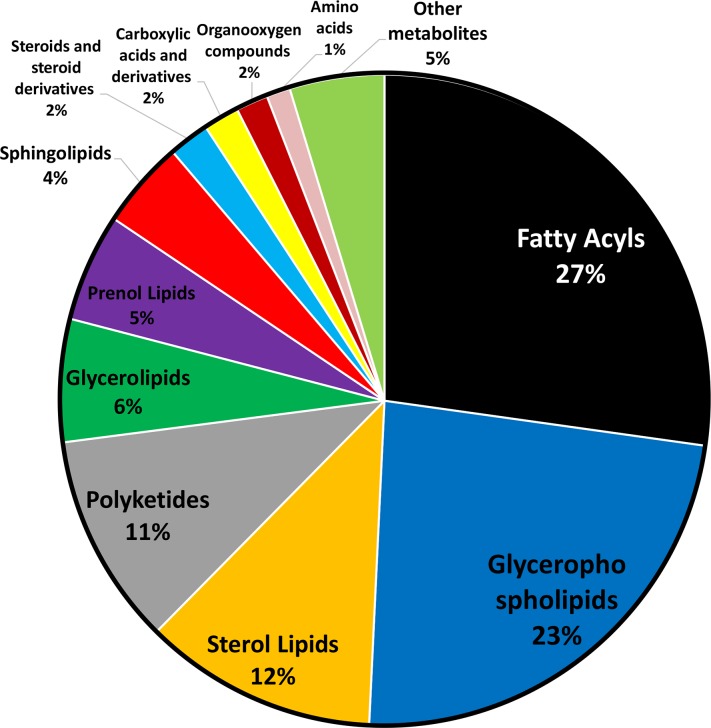
Classification of identified fruit metabolites.Different classifications of fruit metabolites are shown as different colors: Black, fatty acyls. Blue, glycerophospholipids. Orange, sterol lipids. Gray, polyketides. Green, glycerolipids. Purple, prenol lipids. Red, sphingolipids. Light blue, steroids and steroid derivatives. Yellow, carboxylicacids and derivatives. Dark red, organooxygen compounds. Pink, amino acids. Light green, other metabolites.